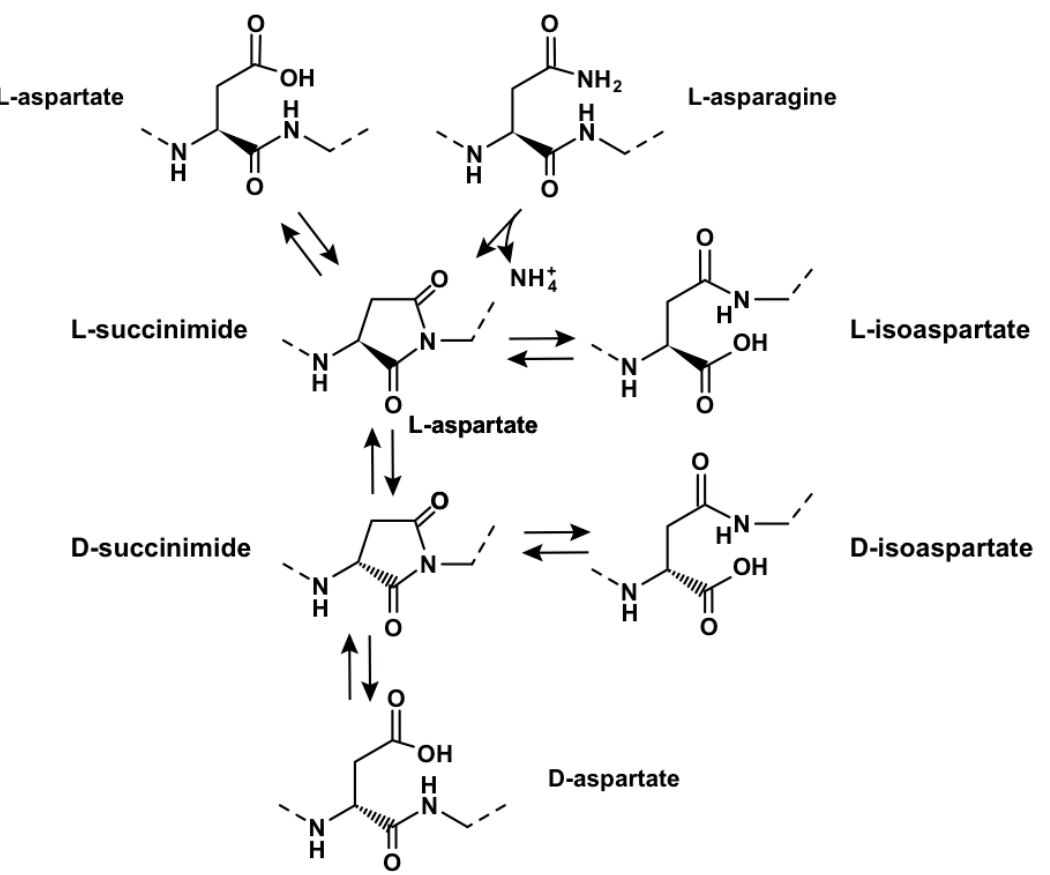
Figure 3. Ageing of aspartate and asparagine residues in the protein